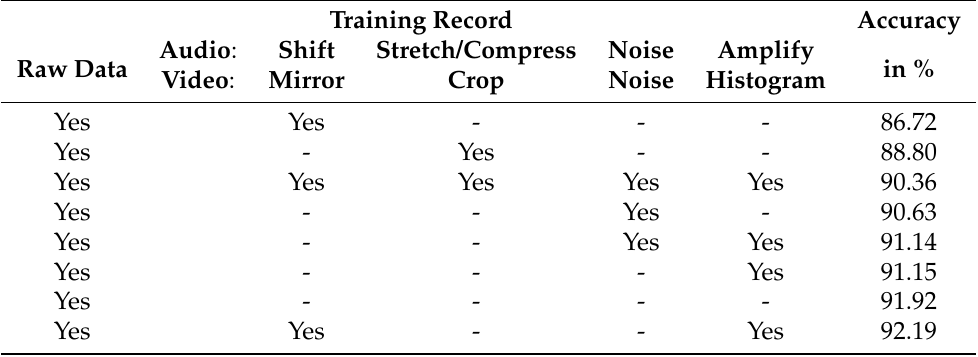
Table 8. Achieved accuracies of audio/video classification on the test dataset, using different combi- nations of the training